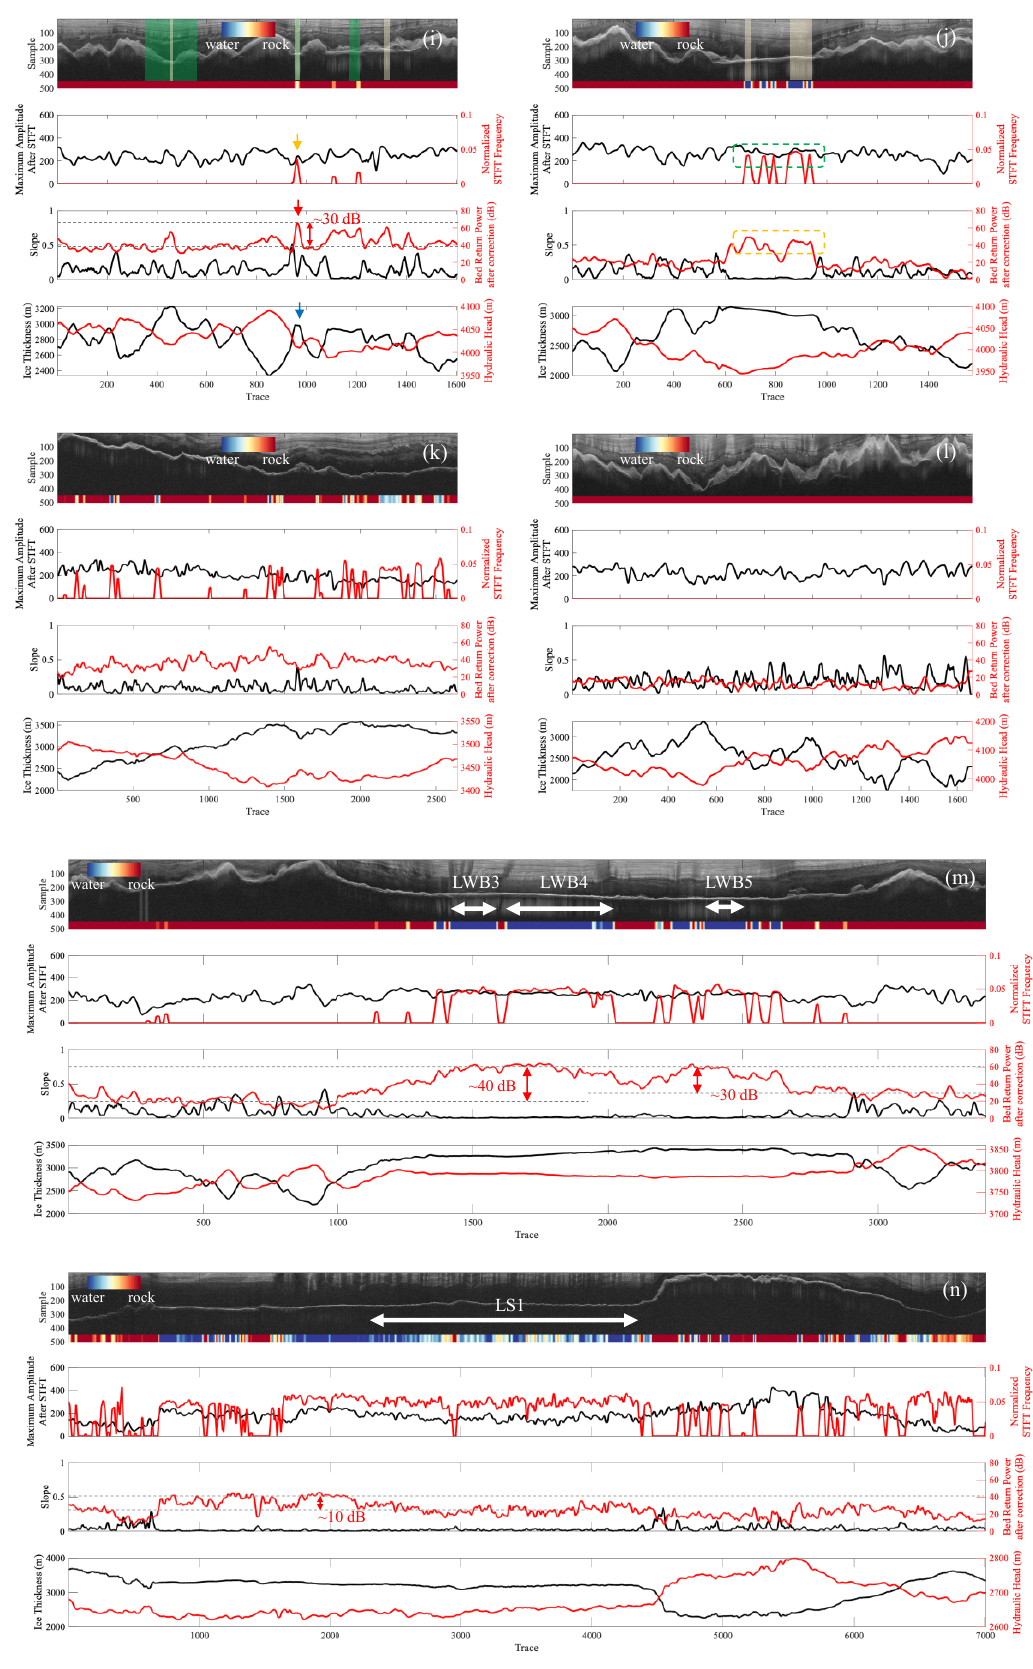
Figure 7. The detection and identification results of basal materials for different radar profiles in the AGAP region. ( a ) The B-scope of radargram frame 20081228_03_006. ( b ) The B-scope of